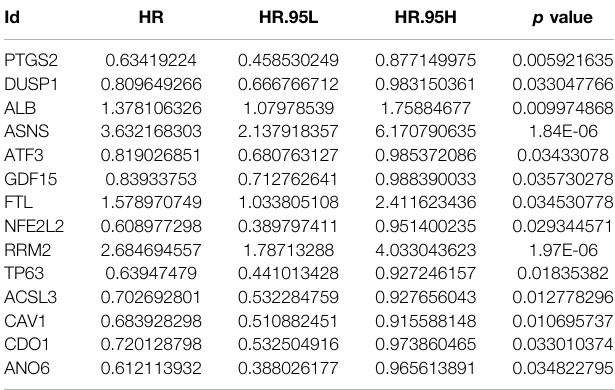
TABLE 3 | Univariable Cox regression analysis to identify DEFRGs related to biochemical recurrence-free survival in whole TCGA cohort.